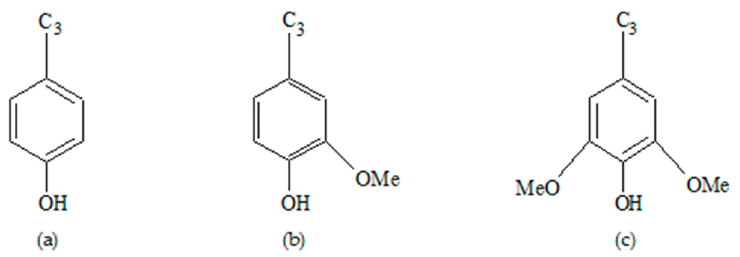
Figure 1. Three kinds of phenyl propane monomer units of lignin, including ( a ) p-hydroxyphenyl propane (H); ( b ) guaiacyl propane (G), and ( c ) syringyl propane (S).